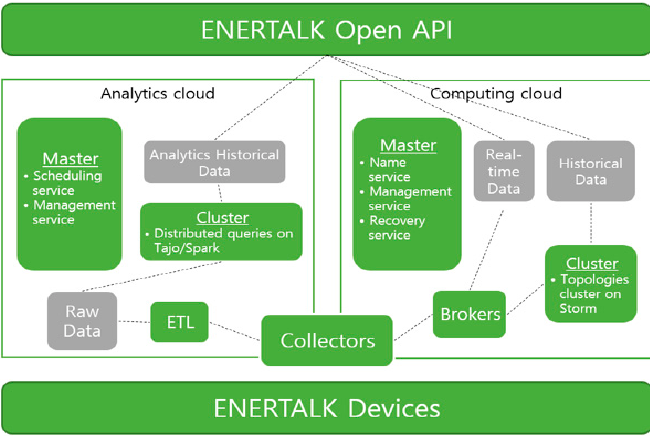
Figure 4. System diagram of the ENERTALK platform.